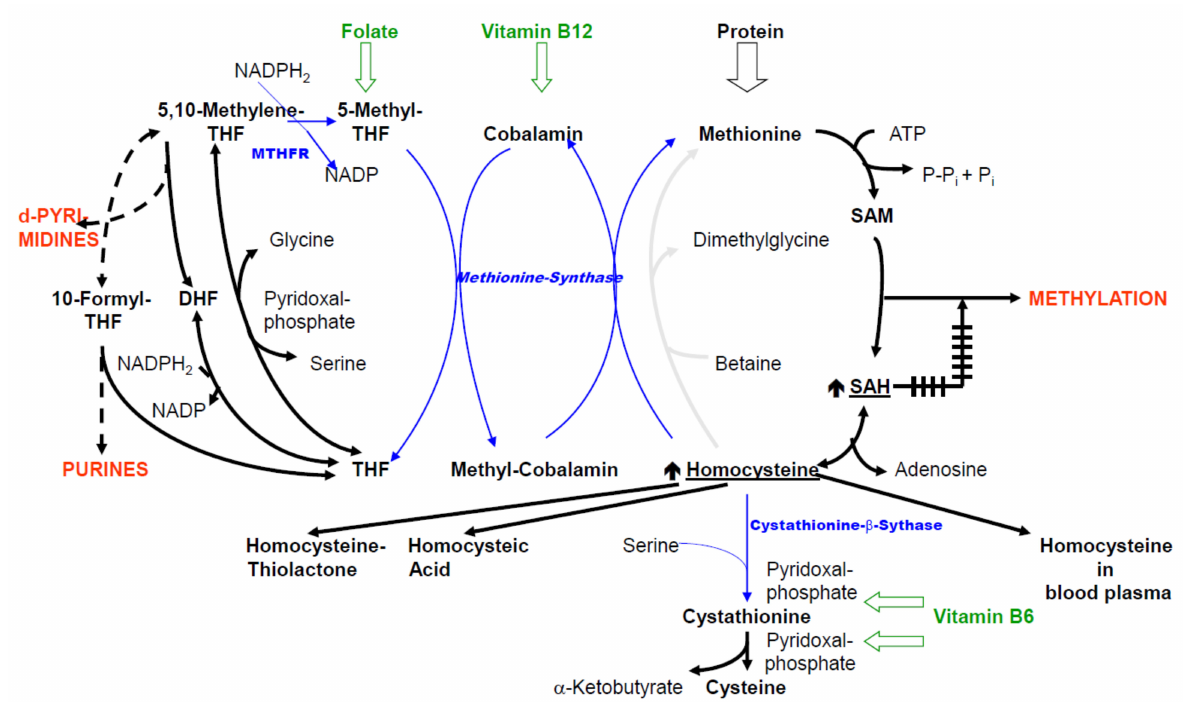
Figure 2. Adaption of the previous chart (colors and abbreviations: see Figure 1 caption): C1 metabolism in the case of vitamin deficiency or genetic enzyme variants; reductions in supply or turnover due to various causes are marked by thinner arrows; inhibitory effects are marked by the crossed-out arrow. Table 1. Frequent causes of C1 metabolic